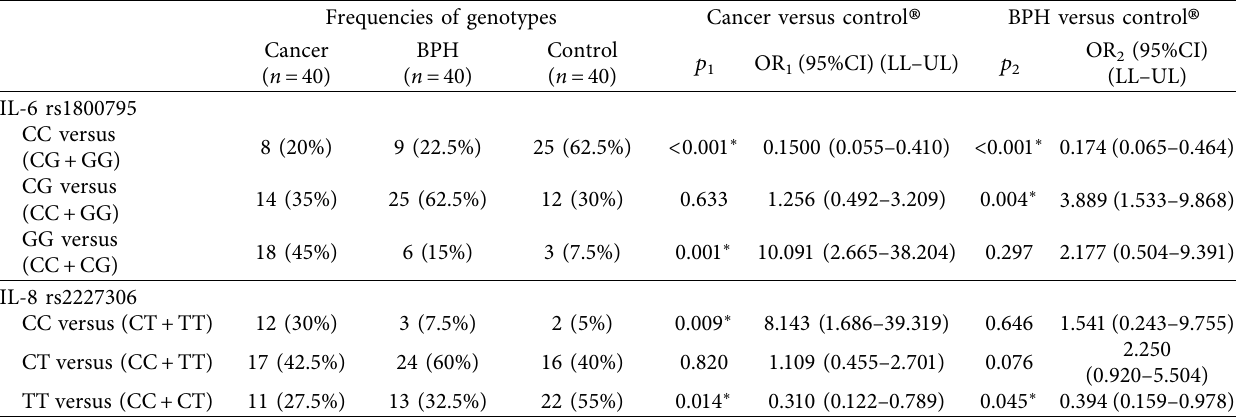
Table 3: Comparison of genotype ratios of IL-6 rs1800795 and IL-8 rs2227306 SNPs in the affected and the control